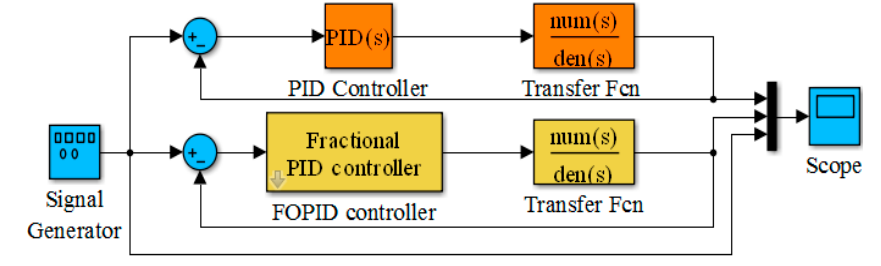
Figure 8. Simulation model diagram.